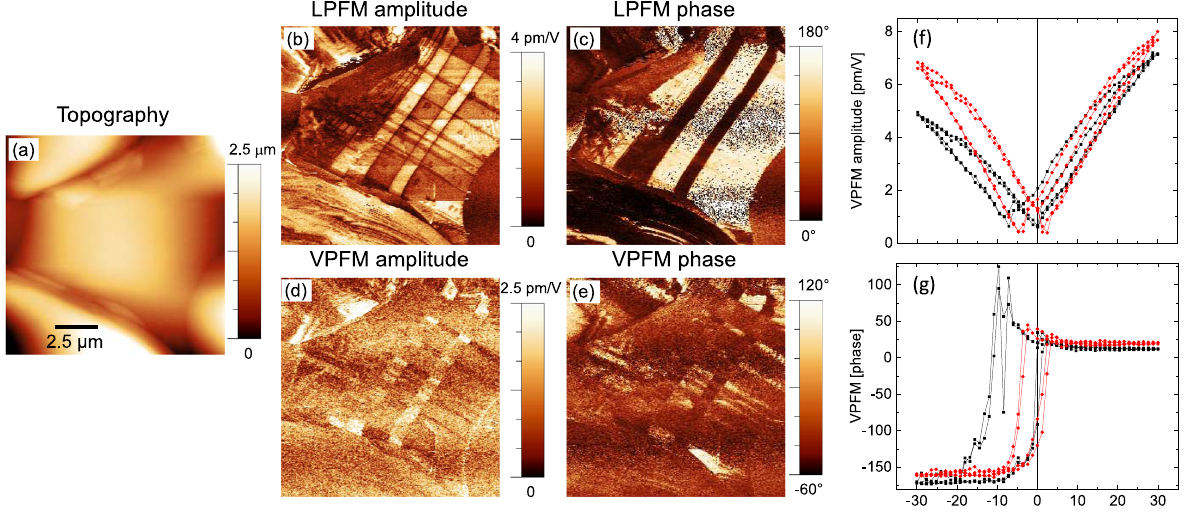
Fig. 3|PFMcharacterizationofbulk γ -BaFe 2 O 4 samples. Topography( a ), lateral PFM ( b , c ), and vertical PFM ( d , e ) images. b , d These show the amplitude of the PFM signals. c , e These show the phase of the PFM signals. Local piezoresponse